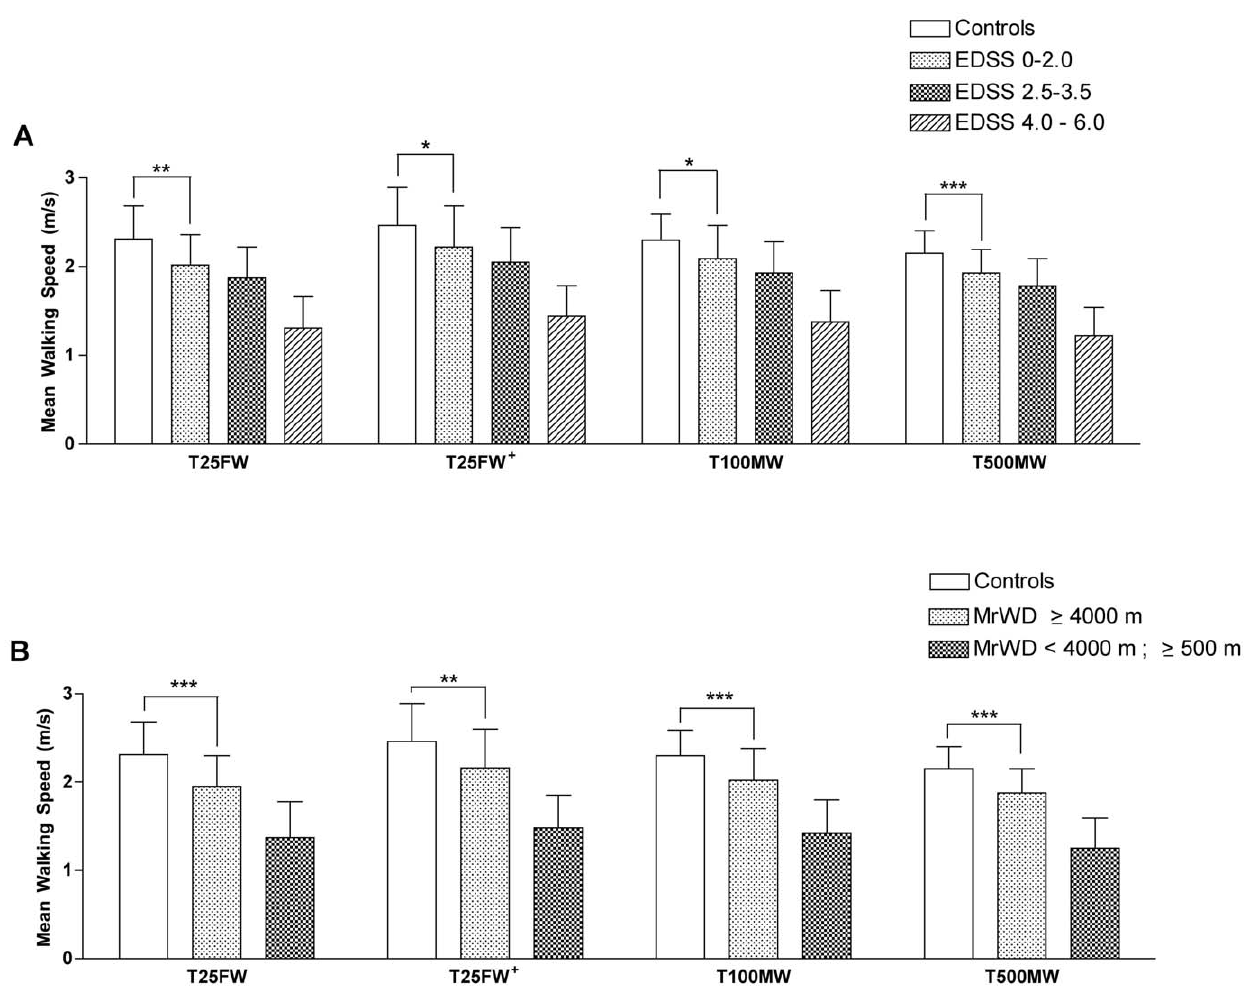
Figure 1. Mean walking speed (MWS) in healthy volunteers and in different subgroups of the pMS population. The same general pattern of MWS differences across the different walking paradigms is observed in every group (T25FW + . T100MW . T25FW . T500MW). In the 4 walking tests, the MWS was significantly slower for each subset of the pMS population compared to healthy volunteers (all p , 0,0001), including pMS with a low level of disability according to their EDSS status (EDSS # 2.0, A) or an apparently unlimited MrWD (MrWD $ 4000 m,